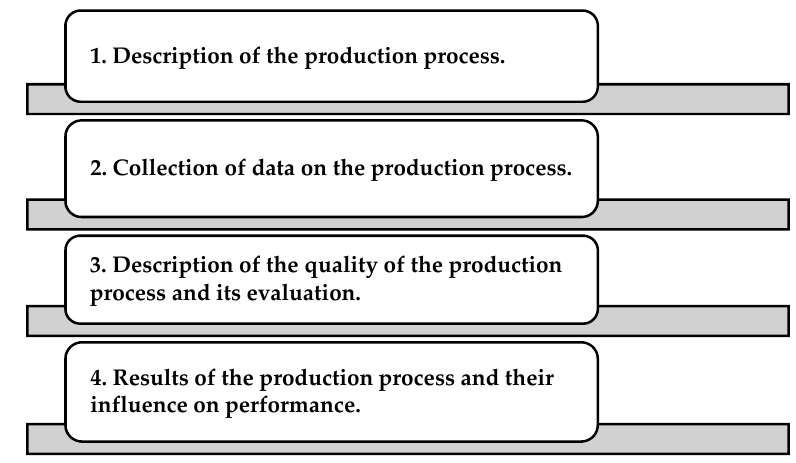
Figure 2. Algorithm of research. Source: own source.